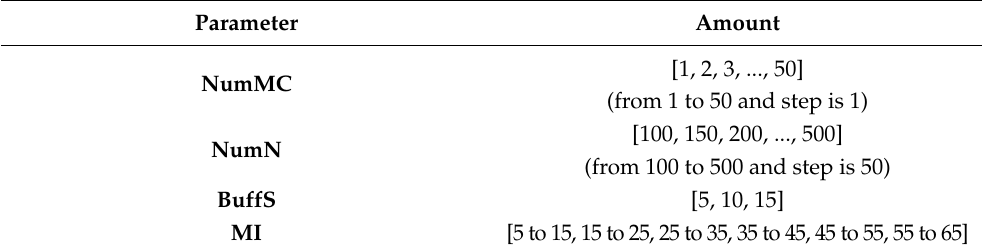
Table 2. Parameter setting for regression